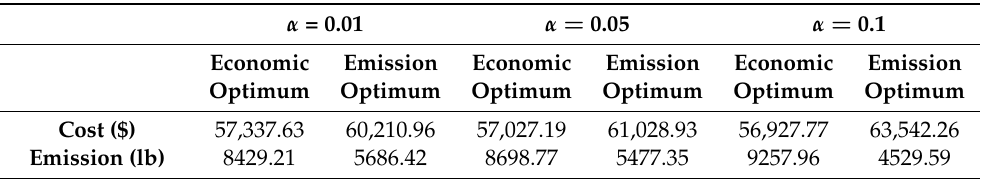
Table 3. Extreme values under different reliability levels.